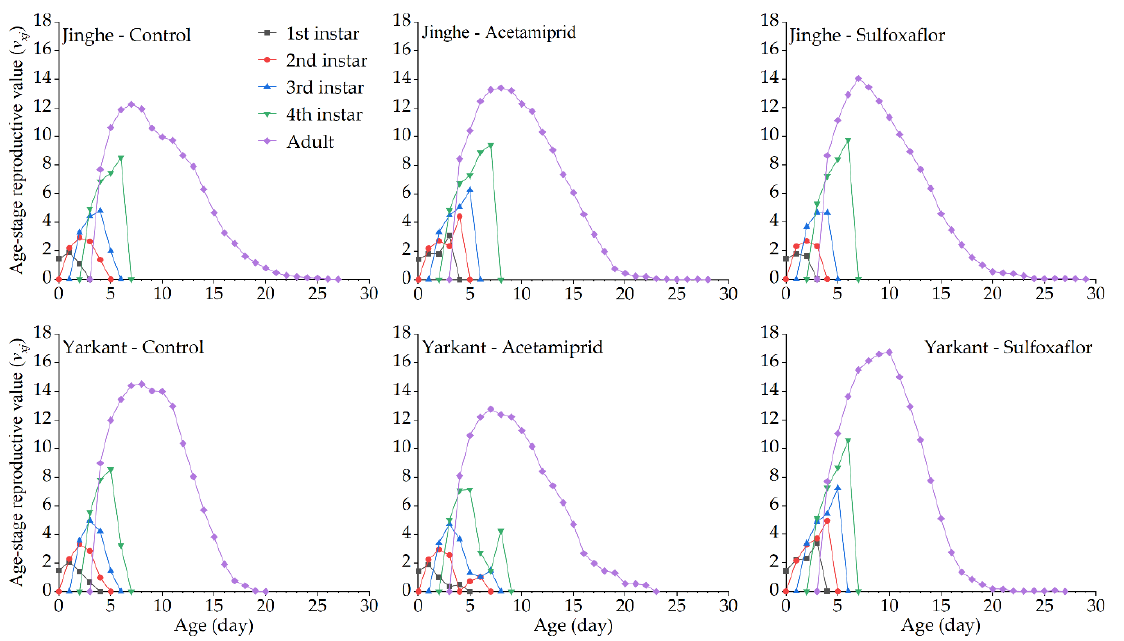
Figure 4. Effects of sublethal concentrations (LC 25 ) of acetamiprid and sulfoxaflor on the age-stage reproductive value ( v xj ) of A. gossypii of the F 1 generation in Yarkant and Jinghe.